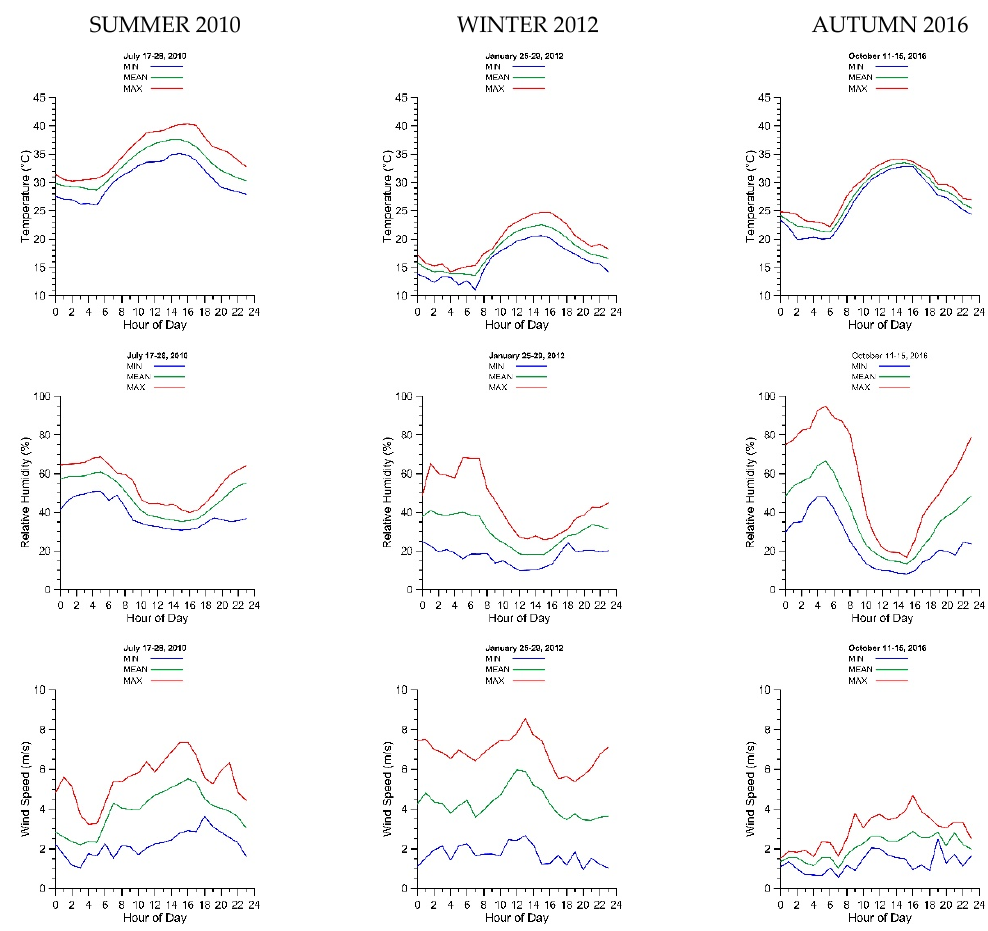
Figure 4. Hourly behaviors of the minimum, mean, and maximum values of temperature, relative humidity, and wind speed during the Cerro Prieto (Mexicali) summer, winter, and autumn